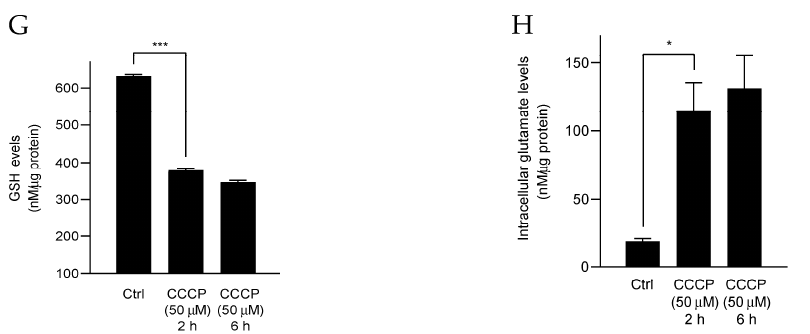
Figure 3. Nemorosone-induced ferroptosis may be associated with mitochondrial uncoupling. ( A ) Phosphorylation control protocol performed by high-resolution respirometry in intact HT1080 cells (1,000,000 cells/mL). After the addition of oligomycin (1.5 µ M), cells were titrated with nemorosone and methylnemorosone in steps of 5 µ M additions, totalizing 30 µ M of both com- pounds in the Oxygraph-2k chambers (2 mL). DMSO was added, similar to nemorosone. The O 2 flow (pmol · s − 1 · mL − 1 ) was inhibited to a constant level after the addition of rotenone–antimycin A mix (0.5 µ M). Every addition is represented by vertical dot lines. ( B ) Oxygen consumption rate (OCR) fold increase was relative to LEAK state (reached after the inhibition of F 1 F O ATP synthase by oligomycin) in HT1080 cells exerted by the separated addition of DMSO (30 µ M), nemorosone (30 µ M), methylnemorosone (30 µ M), and rotenone–antimycin A mix (Rot-Ant, 0.5 µ M). ( C ) Percent- age of cell death at different time points induced by nemorosone (100 µ M) and methylnemorosone (100 µ M) in HT1080 cells, assessed using SytoxGreen dye. ( D ) Analysis using flow cytometry of the C11-BODIPY lipid peroxidation sensor in live HT1080 cells (DRAQ7-negative cells) following nemorosone (100 µ M) or methylnemorosone (100 µ M) treatment at different time points. MFI is the median fluorescence intensity of the fluorophore. ( E ) Percentage of cell death induced by CCCP (12 h, 50 µ M) in HT1080 cells, assessed using SytoxBlue dye. Ferroptosis inhibitors: DFO (50 µ M) and Fer1 (1 µ M). Electron transport chain inhibitors: rotenone (10 µ M) and antimycin A (50 µ M). ( F ) Analysis using flow cytometry of the C11-BODIPY lipid peroxidation sensor in live HT1080 cells (SytoxBlue-negative cells) following CCCP treatment (12 h, 50 µ M). Ferroptosis inhibitors: DFO (50 µ M) and Fer1 (1 µ M). Electron transport chain inhibitors: rotenone (10 µ M) and antimycin A (50 µ M). ( G ) GSH levels in HT1080 cells after treatment with CCCP (50 µ M) during 2 h and 6 h. ( H ) Intracellular glutamate levels in HT1080 cells after treatment with CCCP (50 µ M) during 2 h and 6 h. All quantitative data are shown as mean ± SD from three separate experiments. * p < 0.05, ** p < 0.01, *** p < 0.001, and **** p < 0.0001 determined by unpaired Student’s t -test ( B , D – H ) and by